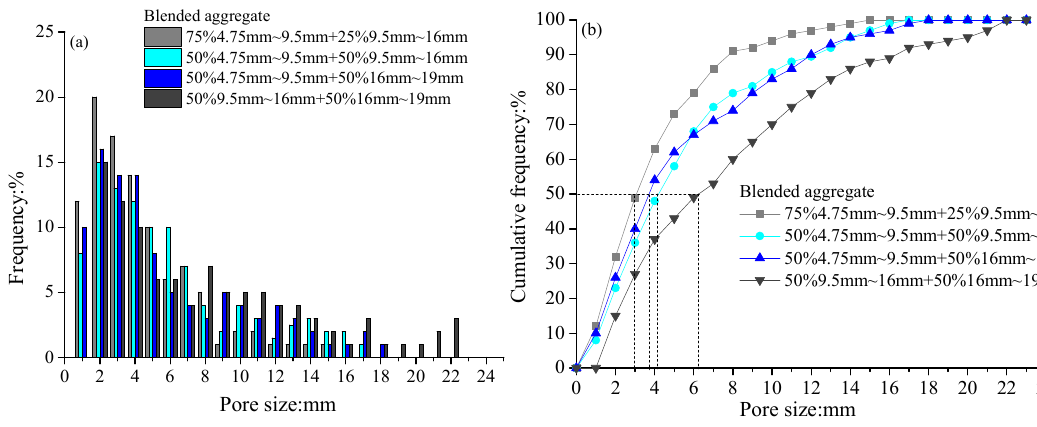
Figure 7. Effect of a blended aggregate on the pore distribution of pervious concrete. ( a ) Frequency distribution of pore sizes; ( b ) cumulative frequency distribution of pore sizes. The design porosity was 15%. The figure shows the average value of three to five specimens.